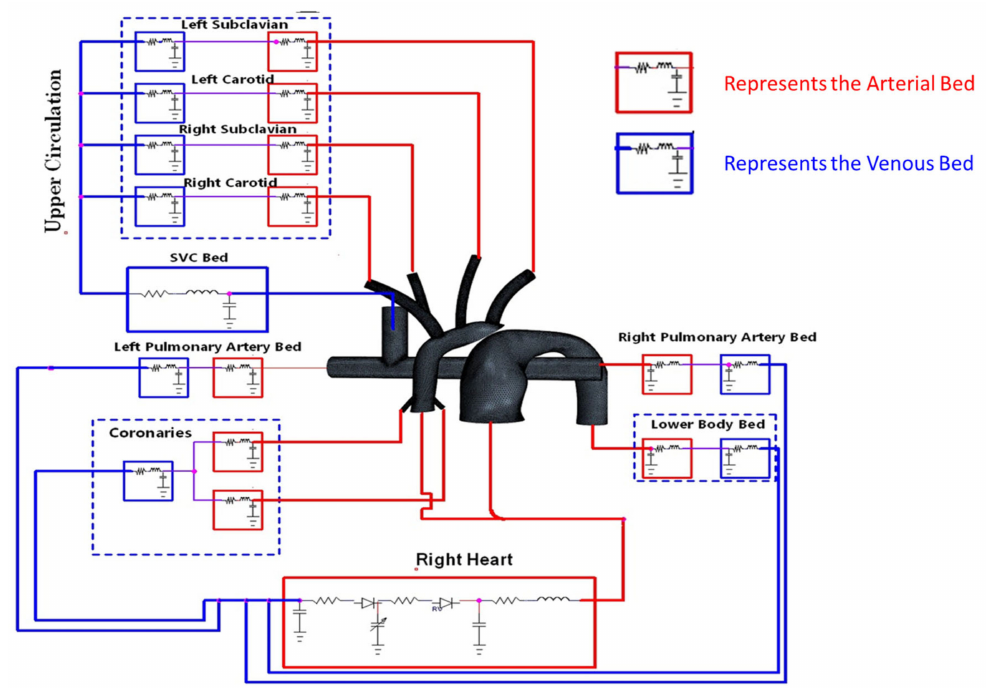
Figure 7. Multiscale model of the HCSII circulation, three-dimensional CFD model coupled with the lumped parameter